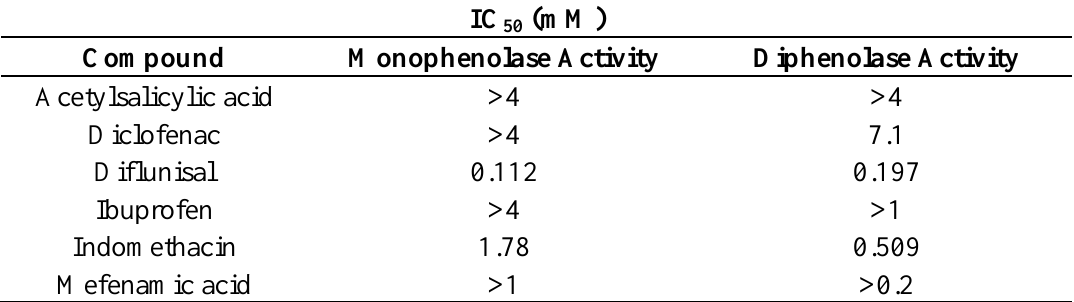
Table 1. IC values of NSAIDs on monophenolase activity and diphenolase 50